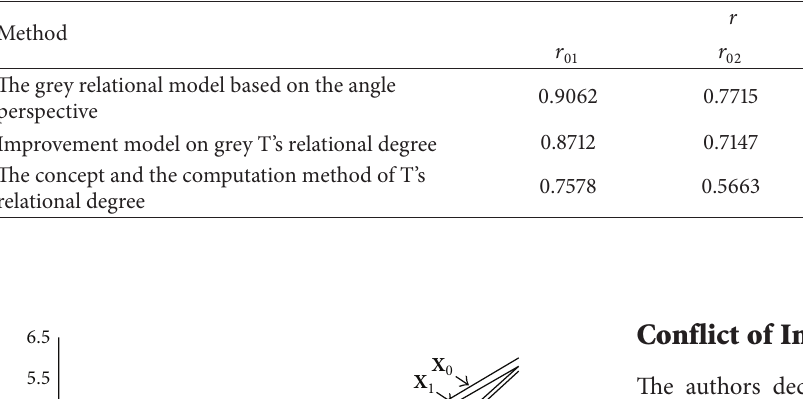
Table 4: Result comparisons of three different methods.